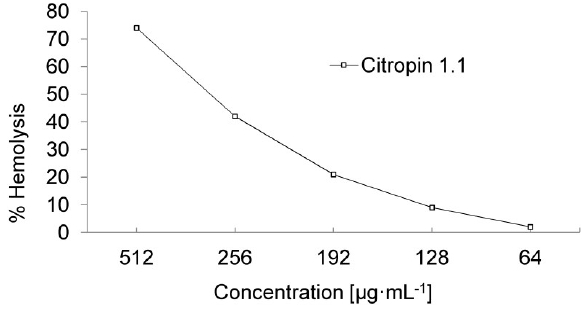
Figure 3. Hemolysis of hRBC as a function of CIT concentration.